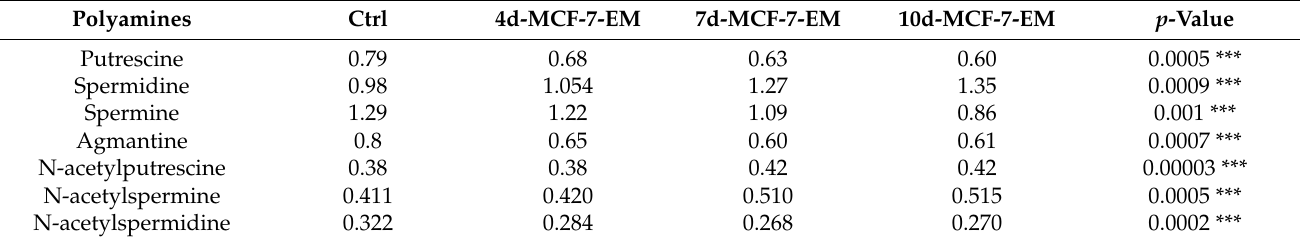
Table 2. Amounts of polyamines (ng/mL) in 4d-MCF-7-EM, 7d-MCF-7-EM, or 10d-MCF-7-EM and MCF-7 fresh medium (Ctrl). The p -value is related to the change in concentration of the analytes listed in the table in the medium analyzed. Polyamines